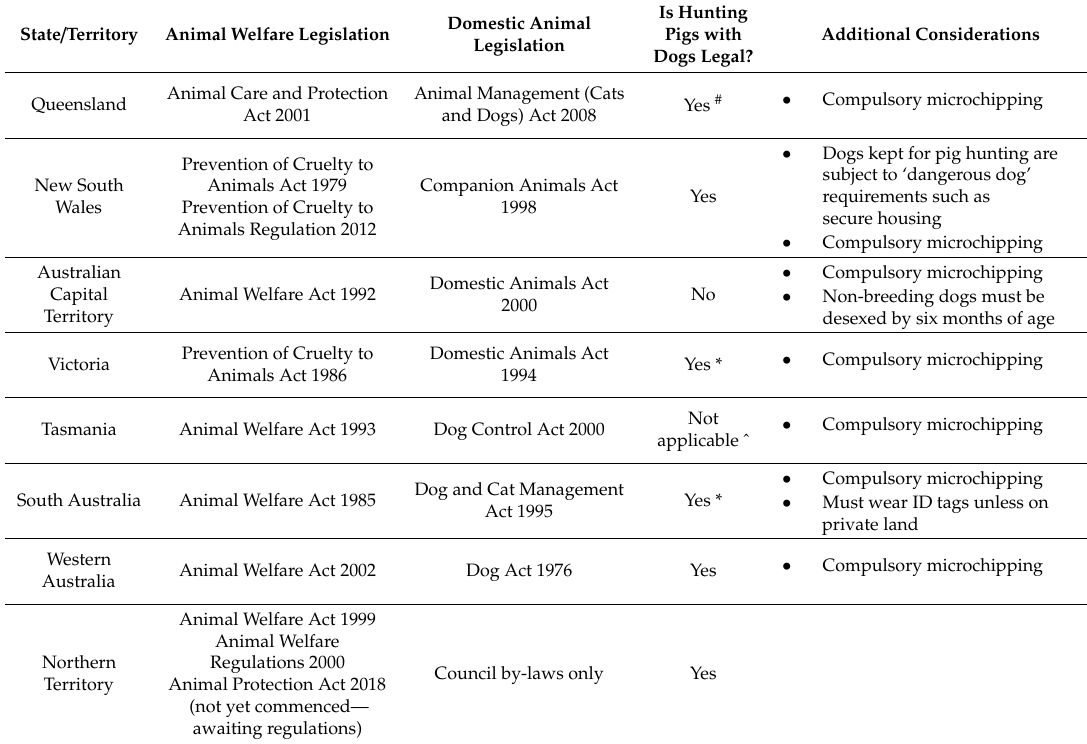
Table 1. Legislation relating to pig-hunting dogs in